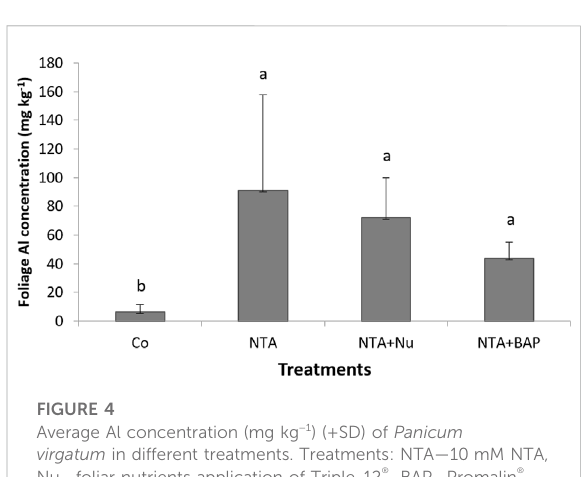
FIGURE 4 Average Al concentration (mg kg − 1 ) (+SD) of Panicum virgatum in different treatments. Treatments: NTA — 10 mM NTA, Nu — foliar nutrients application of Triple-12 ® , BAP- Promalin ® foliarapplicationMeansforcolumnswithsamelettersarenot signi fi cantly different ( α = 0.05).